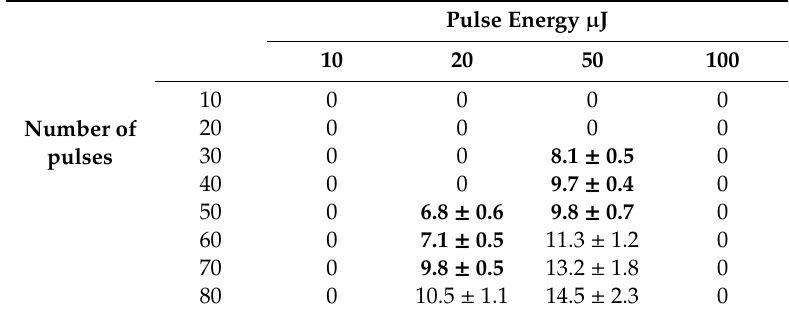
Table 1. The diameters ( µ m) of the holes for applied graphene paper laser ablation parameters.